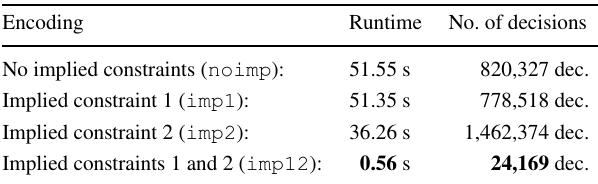
Table 4 Runtime and number of decisions required to solve the